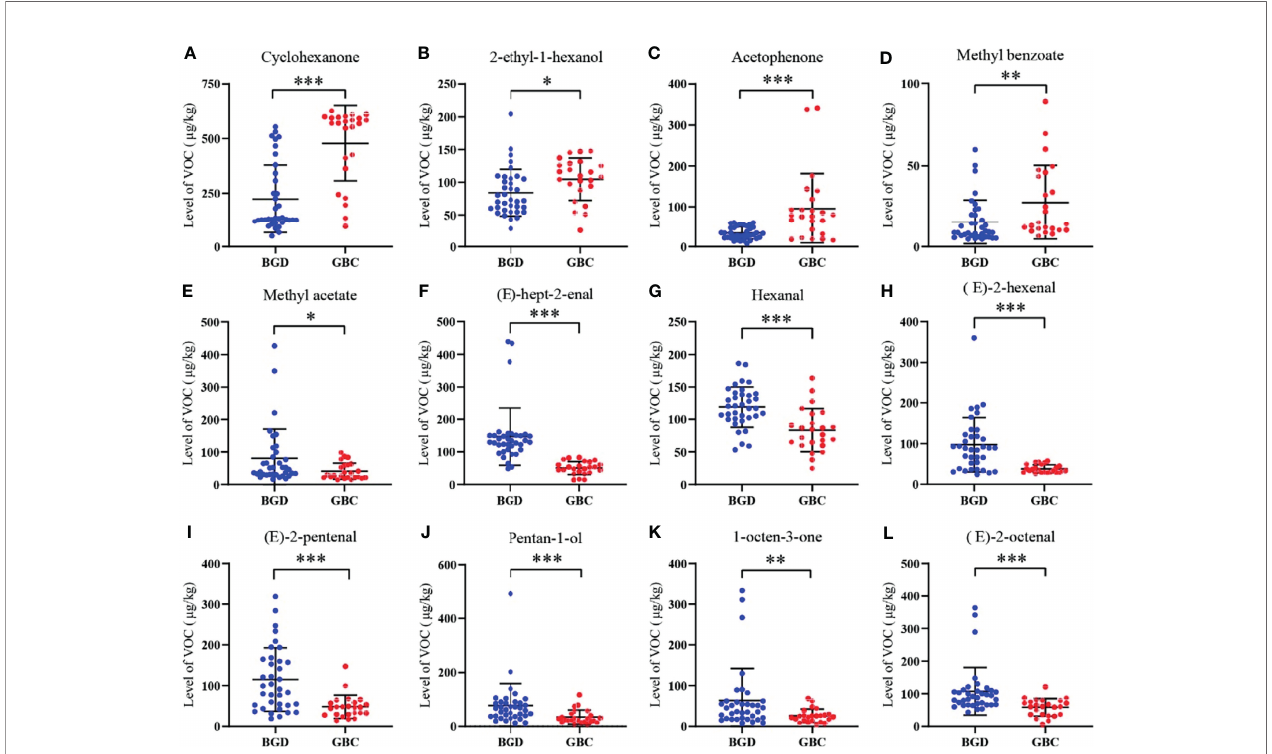
FIGURE 3 | Quantitative analysis of VOCs in the training cohort. The levels of Cyclohexanone (A) , 2-ethyl-1-hexanol (B) , Acetophenone (C) , Methyl benzoate (D) , Methyl acetate (E) , (E)-hept-2-enal (F) , Hexanal (G) , (E)-2-hexenal (H) , (E)-2-pentenal (I) , Pentan-1-ol (J) , 1-octen-3-one (K) , (E)-2-octenal (L) . *P < 0.05, **P < 0.01, ***P < 0.001(Mann – Whitney U test). Data represents the median (interquartile range).